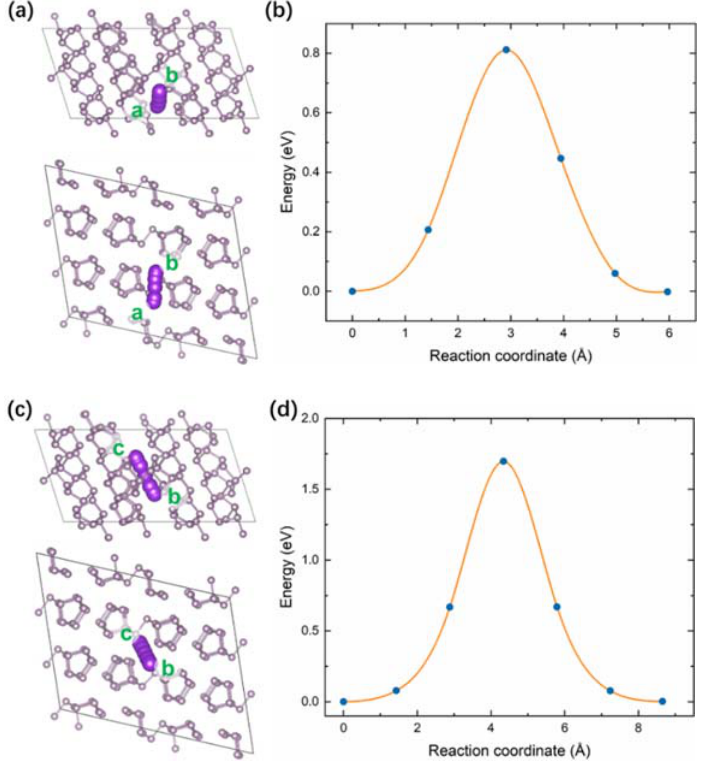
Figure 8. Schematic diagram of diffusion pathway in the RP ( a ) from site a to b, and ( c ) from site c to b. The energy profile of the K + diffusion of the two pathways is shown in ( b , d ), respectively.